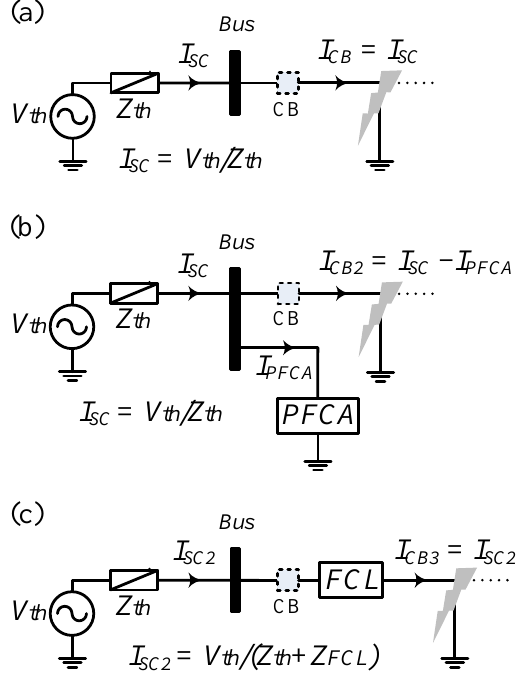
Figure 1. Parallel fault current attenuator (PFCA) current attenuation method: ( a ) base case; ( b ) PFCA solution; ( c ) fault current limiter (FCL) solution.